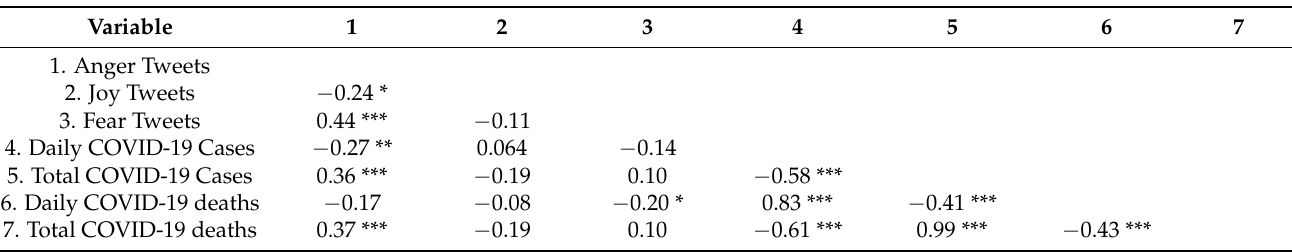
Table A1. Milan Pearson’s correlation coefficient